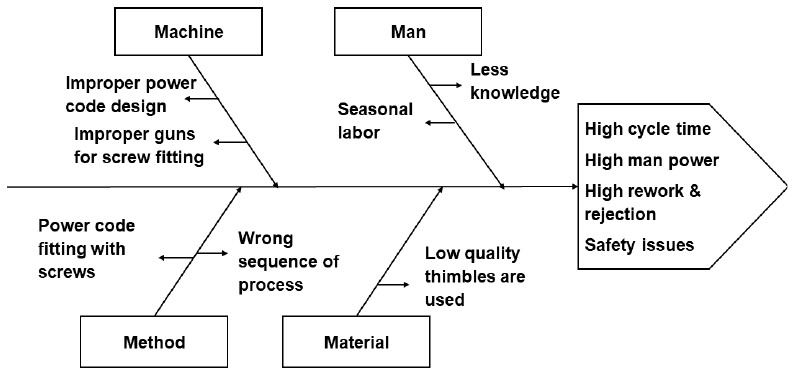
Figure 5. Fishbone diagram for power cord process.